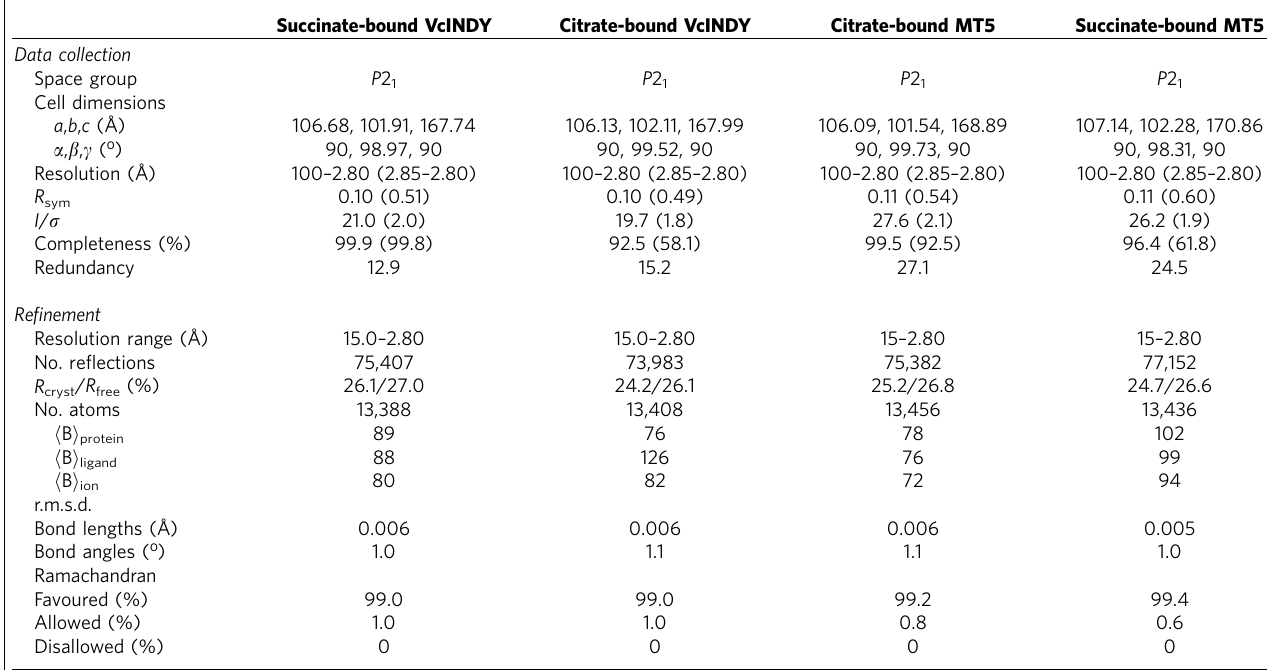
Table 1 | Data collection and refinement